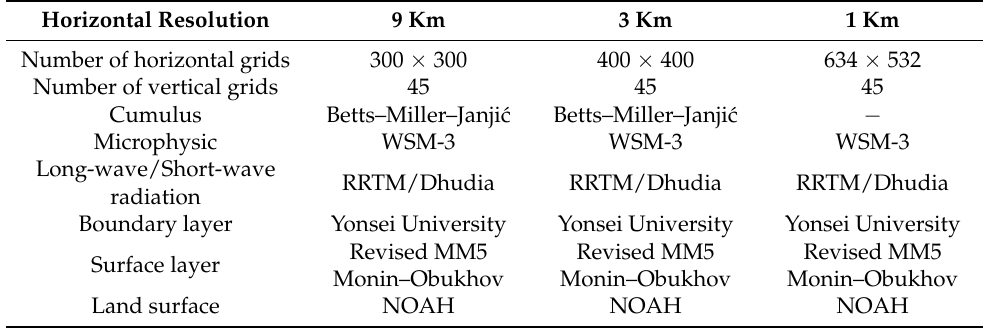
Table 1. WRF model configuration for simulating precipitation in eastern